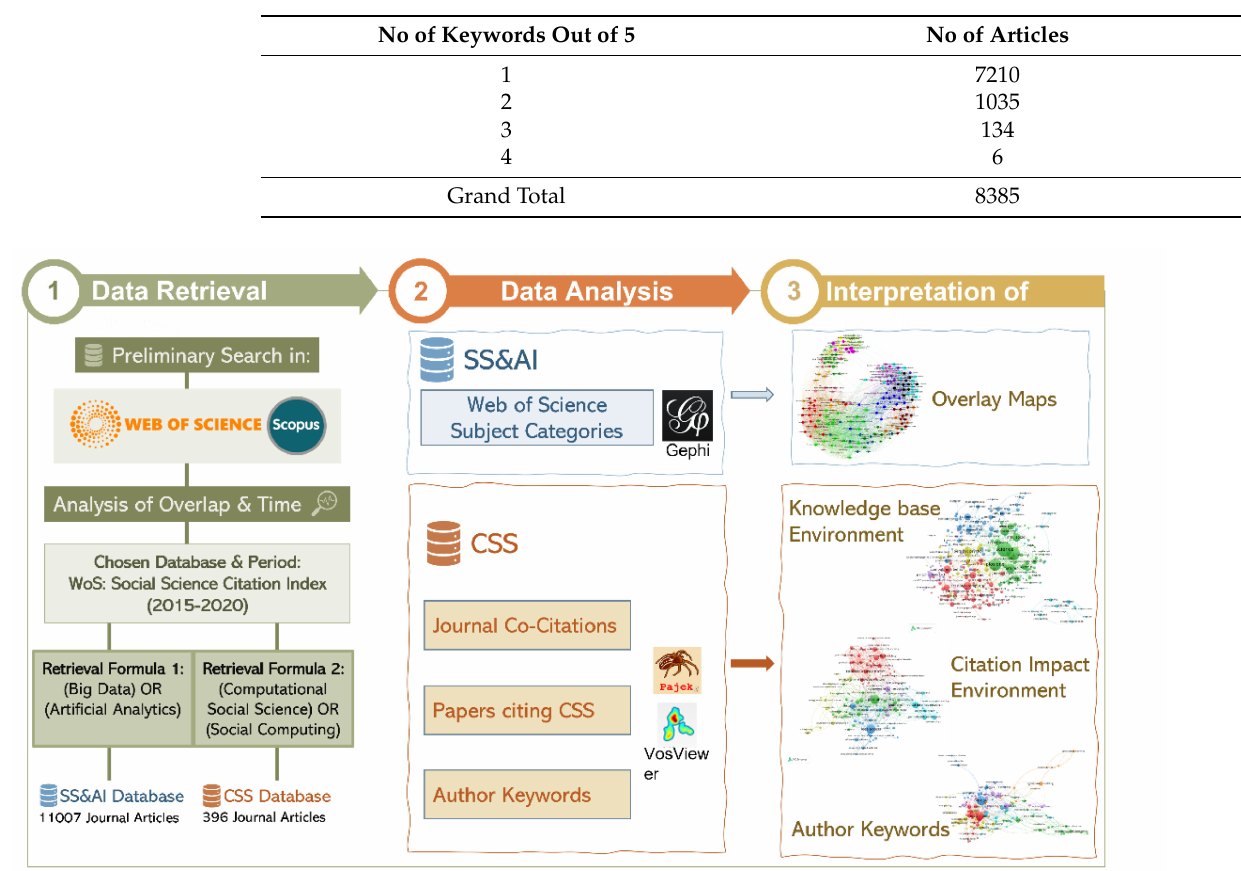
Table 1. Overlaps for 5 keywords (Big Data, Artificial Intelligence, machine learning, neural networks, natural language processing) for 2018 publications in social sciences. Source: WoS.